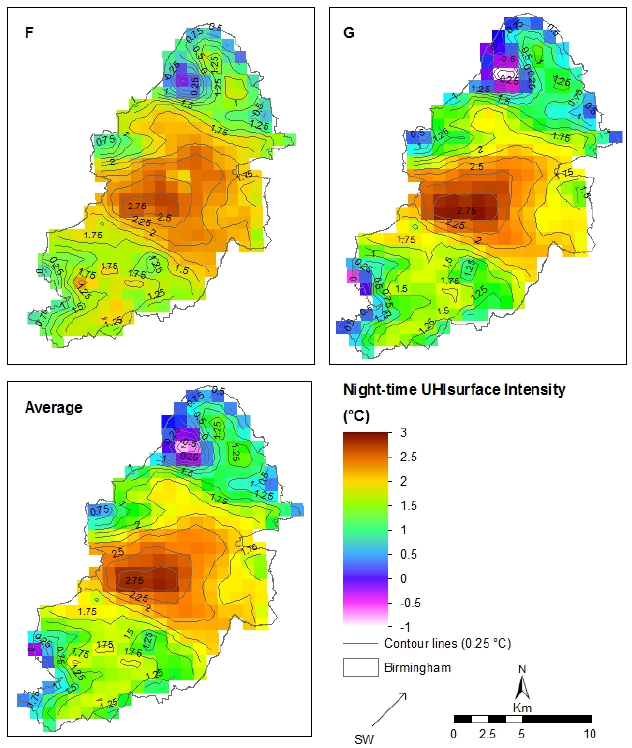
Figure 4. Night-time UHI surface intensity, for Pasquill-Gifford Stability Classes ( F ) and ( G ), and Average for June, July, August 2013 and prevailing wind direction for the period. Based on MODIS Aqua LST product.